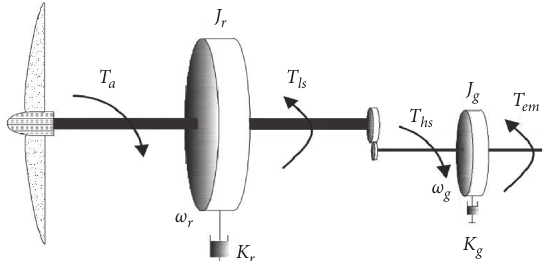
Figure 8: Schematic diagram of the drive train.